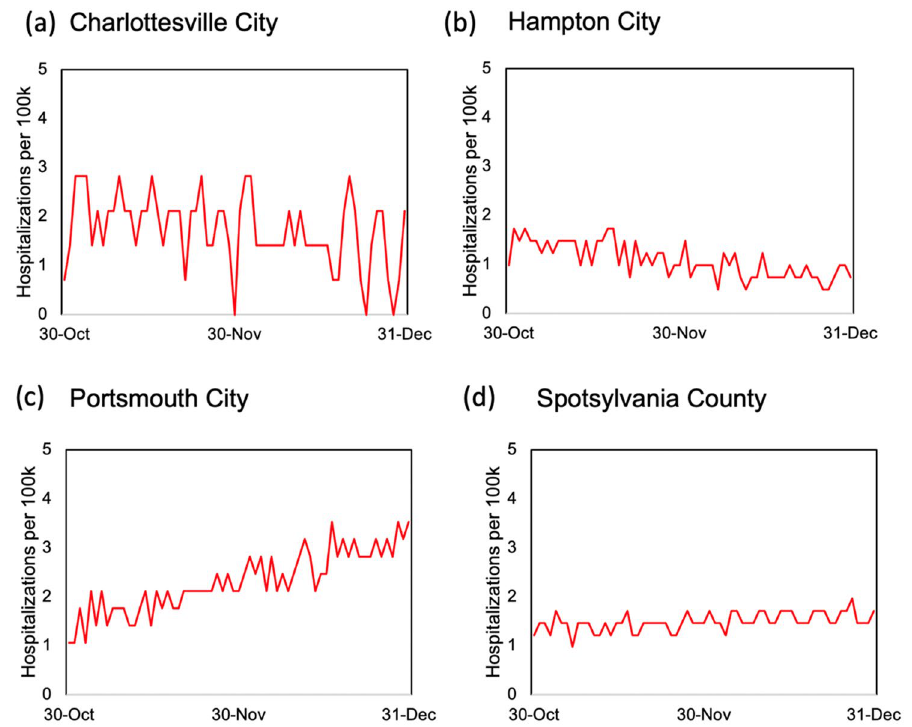
Figure 6. Three-day average of new COVID-19 hospitalizations per 100,000 persons projections based on the mean estimated RE t values for four localities in Virginia: ( a ) Charlottesville City, ( b ) Hampton City, ( c ) Portsmouth City, and ( d ) Spotsylvania